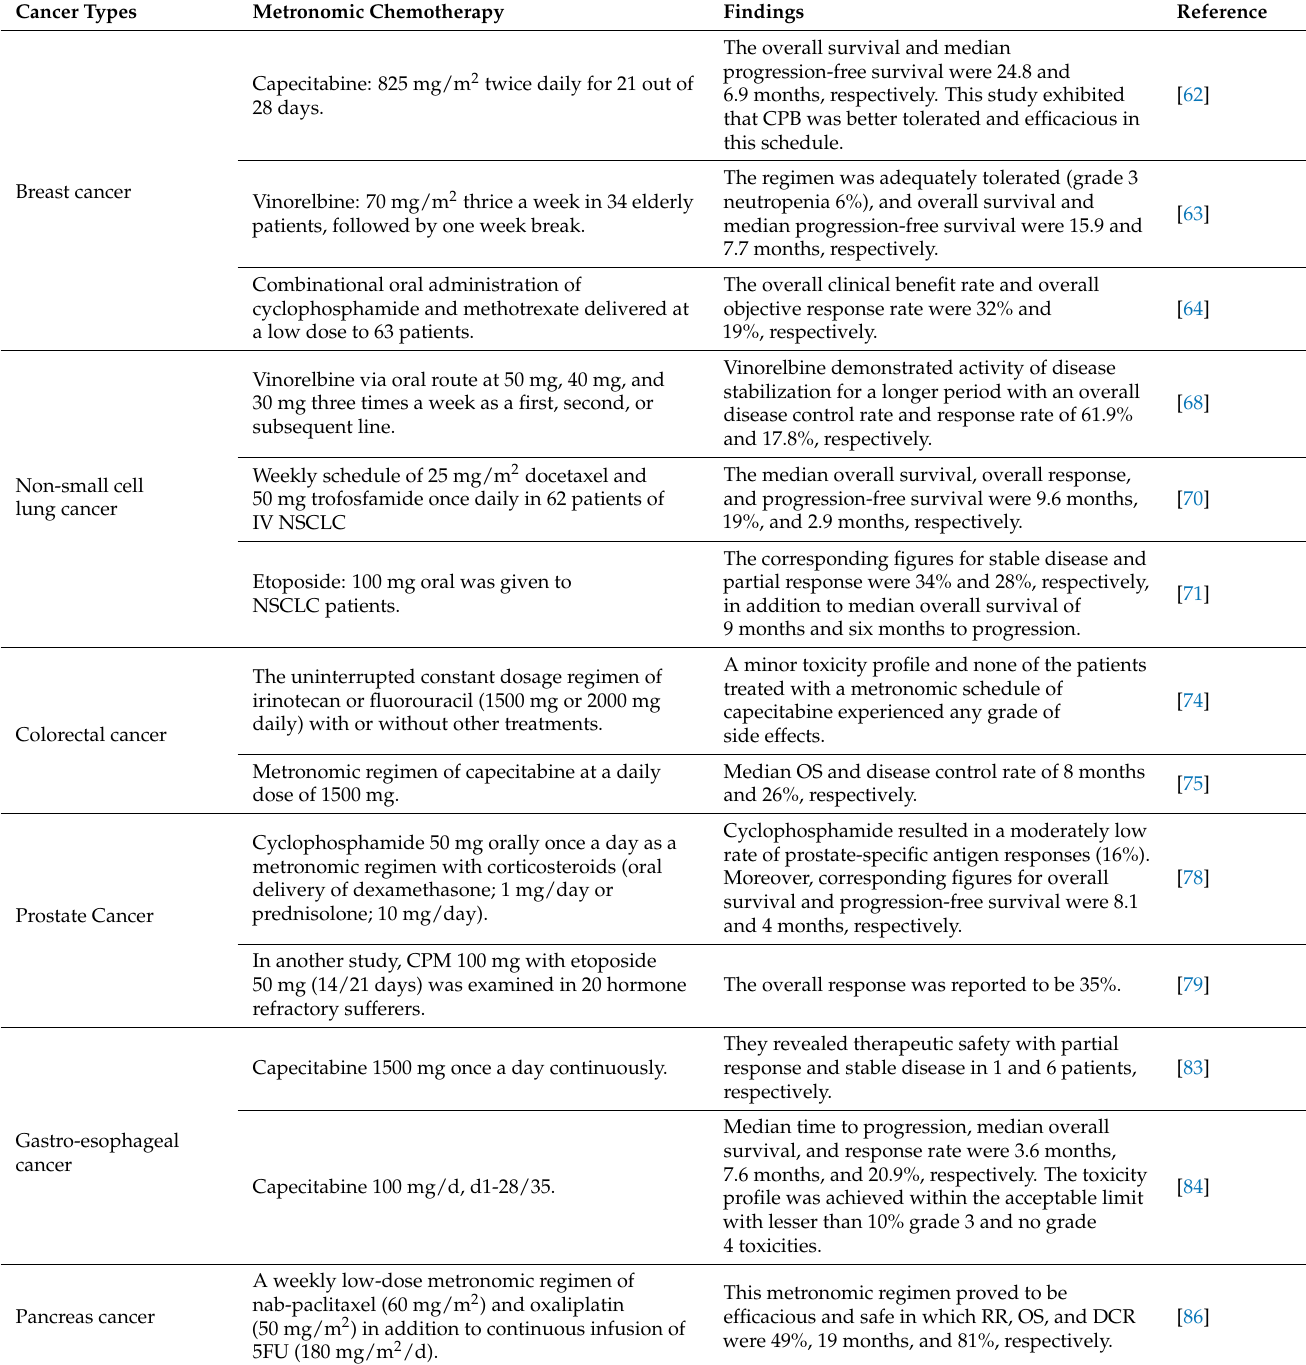
Table 2. Metronomic chemotherapy for various